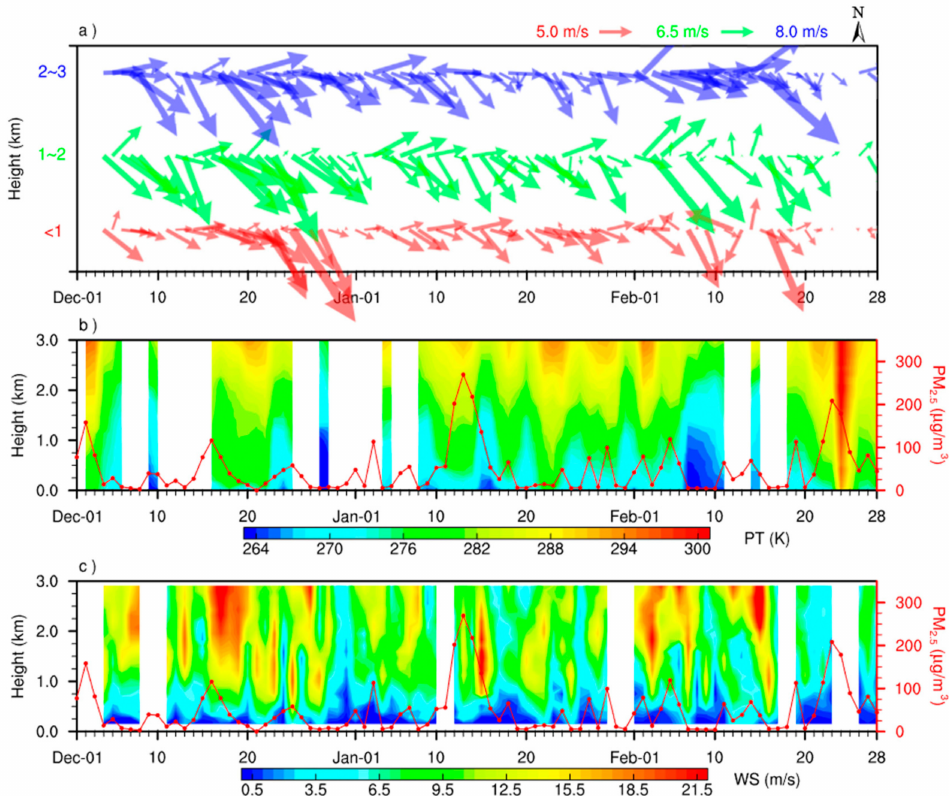
Figure 2. ( a ) Time series of the horizontal averaged wind vectors as derived from the Radar Wind Profiler (RWP) in Beijing for the altitude ranges from the surface to 1 km (SFC–1 km), 1–2 km, and 2–3 km above ground level (AGL), which are denoted as the red, green, and blue vectors, respectively. The wind arrow is the direction towards which the wind is blowing, and the width of the wind vector is proportional to the wind speed. Time-height cross-sections of ( b ) potential temperature (PT, color shaded) from radiosonde measurements and ( c ) horizontal wind speed (color shaded) from RWP, overlaid with observed ground-level PM 2.5 concentration (red lines). All these measurements were obtained at 0800 BJT during the period December 1, 2018, to February 28,